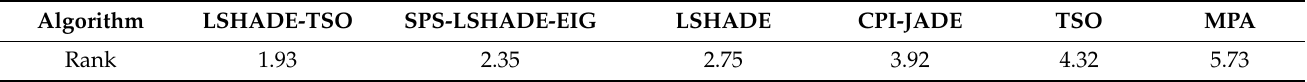
Table 2. Friedman test